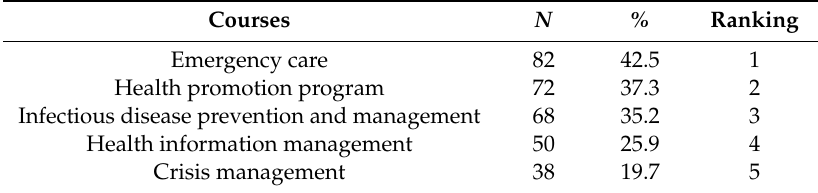
Table 3. The top five training courses from the previous year (multiple-choice) ( N = 193). Courses N % Ranking Emergency care 82 Health promotion program